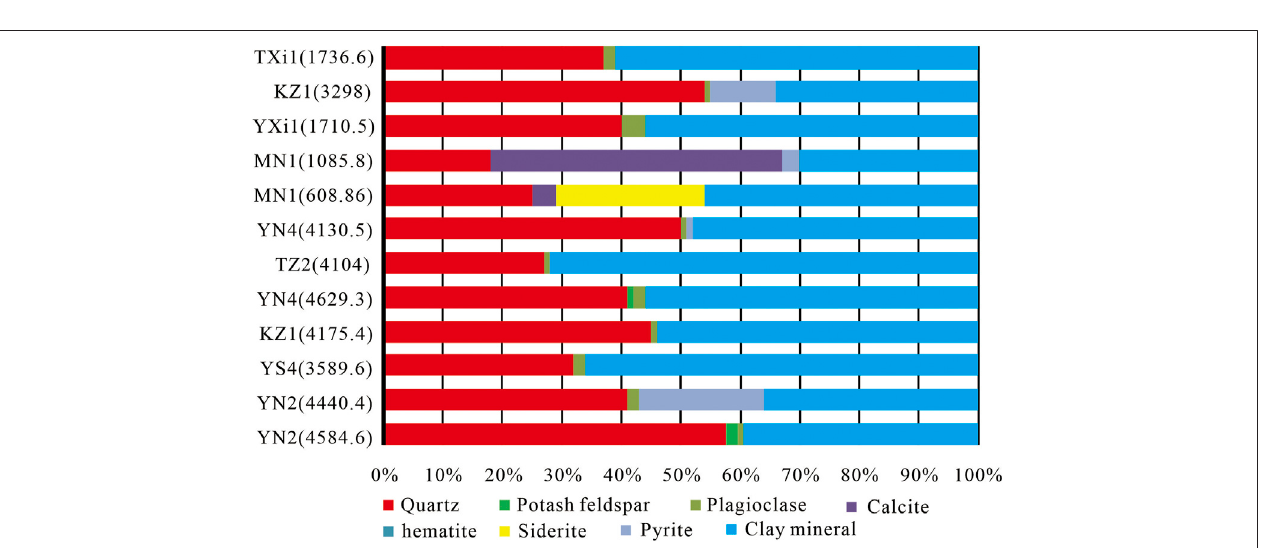
Frontiers in Earth Science |